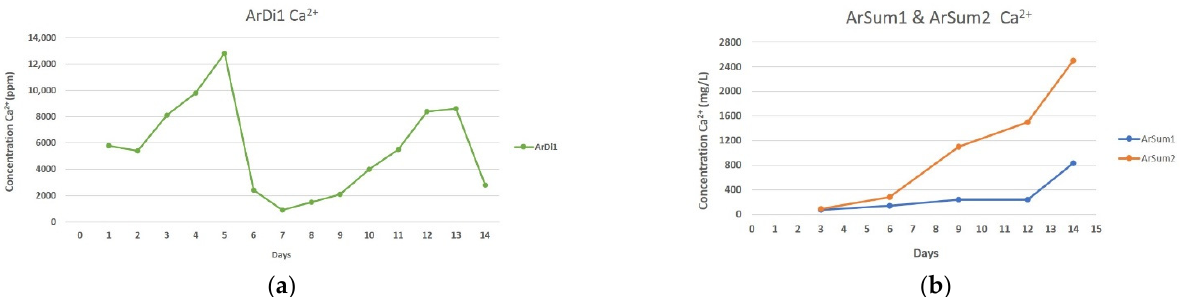
Figure 7. Ca 2+ concentration in ( a ) sample ArDi1 drain outlet, ( b ) and in sample ArSum1 and ArSum2 drain outlet Ca 2+ concentration.